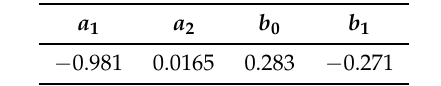
Table 2. Estimation result of the coefficients of the ARX inverse model.